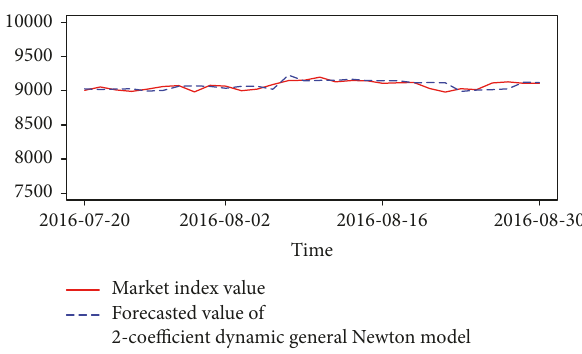
Figure 17: Time plots of raw data and the forecasts of model D.